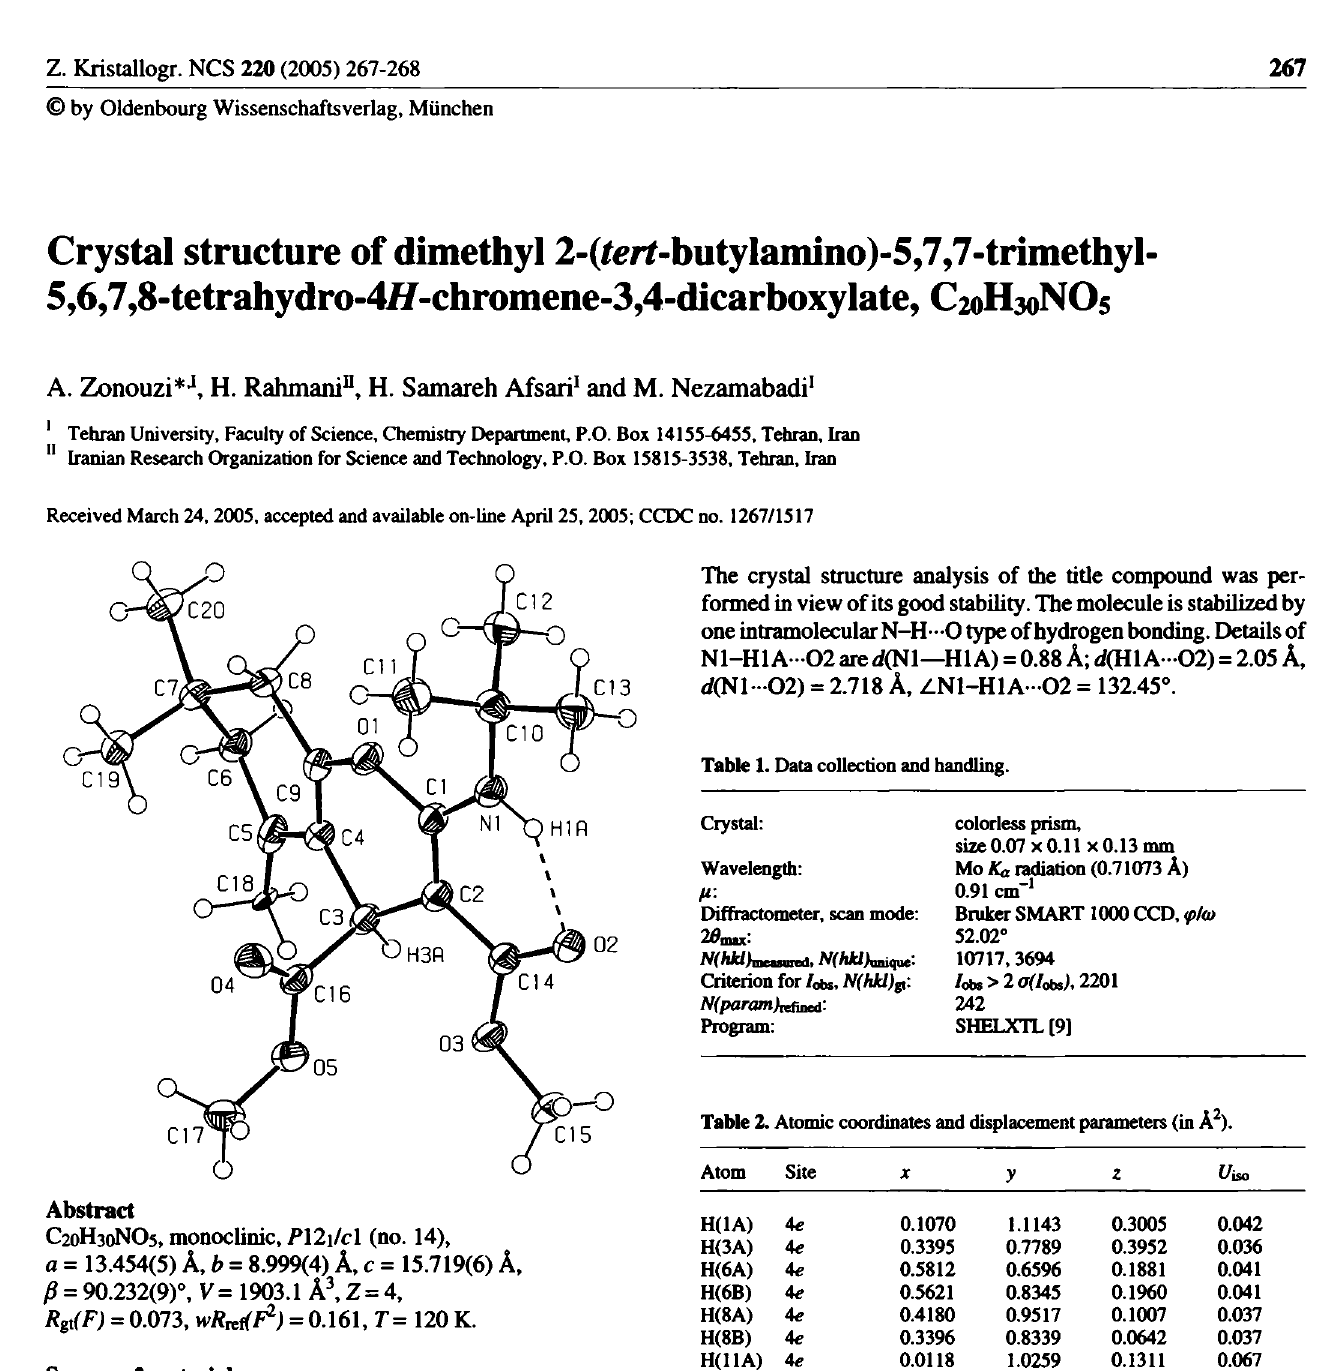
Table 2. Atomic coordinates and displacement parameters (in A 2